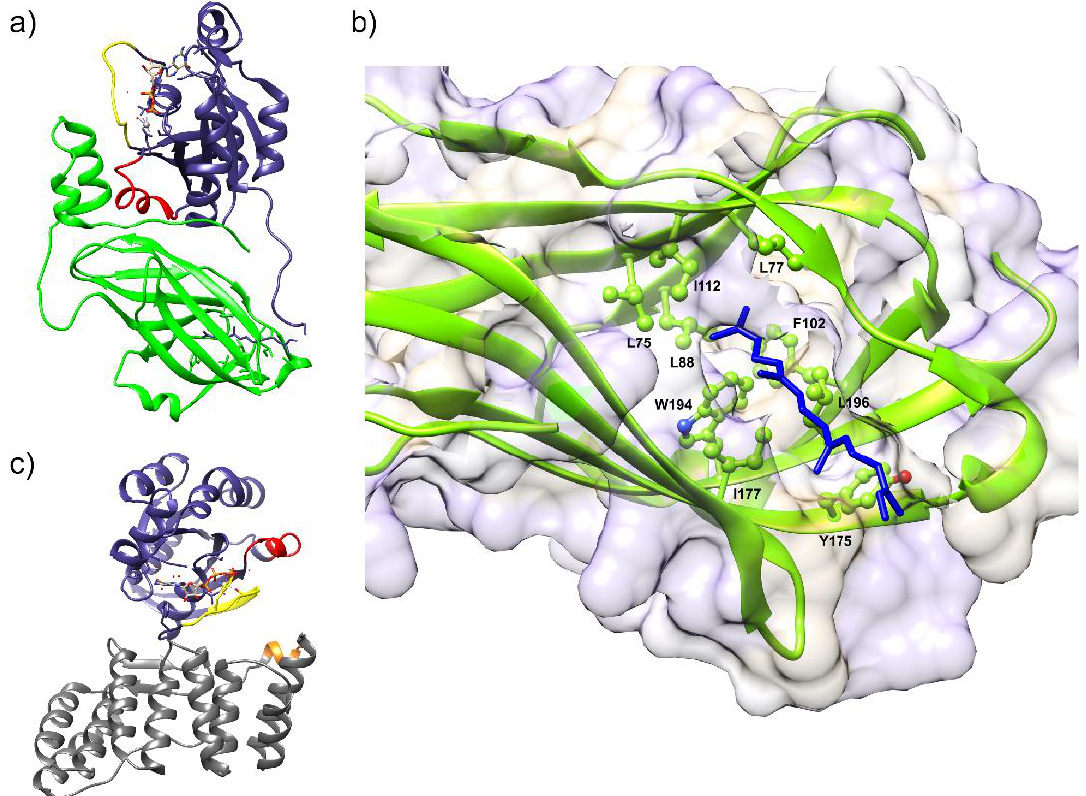
Figure 8. Atomic structure of Rac in interaction with RhoGDI or with p67 phox . The structure was solved by X-ray diffraction at a 2.7 Å resolution [50]. ( a ) Rac is represented in blue ribbon and RhoGDI in green. The GDP molecule is depicted in stick (white) within Rac, while the geranylgeranyl tail of Rac is represented as stick (dark blue) within RhoGDI. The switch I and II regions of Rac are highlighted in yellow and red, respec-tively. ( b ) Binding pocket of the geranylgeranyl tail. The Rac geranylgeranyl tail, represented in blue stick, binds in a hydrophobic cavity formed by RhoGDI, represented in green ribbon and surface. The hydrophilic regions of the RhoGDI-binding pocket are colored in purple, hydrophobic regions in orange. The hydrophobic residues of RhoGDI involved in interactions with the lipidic group are labeled. ( c ) Atomic struc- ture of Rac in complex with p67 phox . The structure of the Rac-p67 phox complex (1E96) [49], solved by X-ray diffraction at a 2.4Å resolution, was structurally aligned with the structure of the N-ter extremity of p67 phox (1HH8) [50]. Rac is represented in blue ribbon with switch I and II regions highlighted in yellow and red, respectively. p67 phox is represented in gray ribbon, the activation domain is represented in orange.